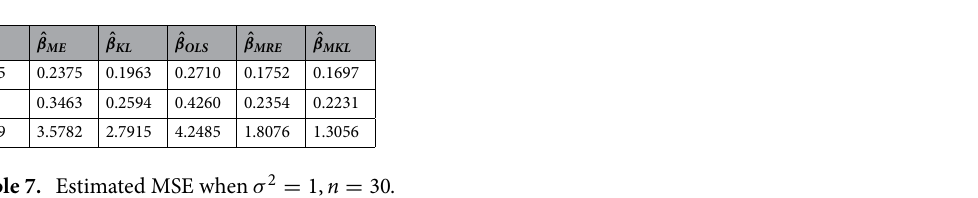
Table 7. Estimated MSE when σ